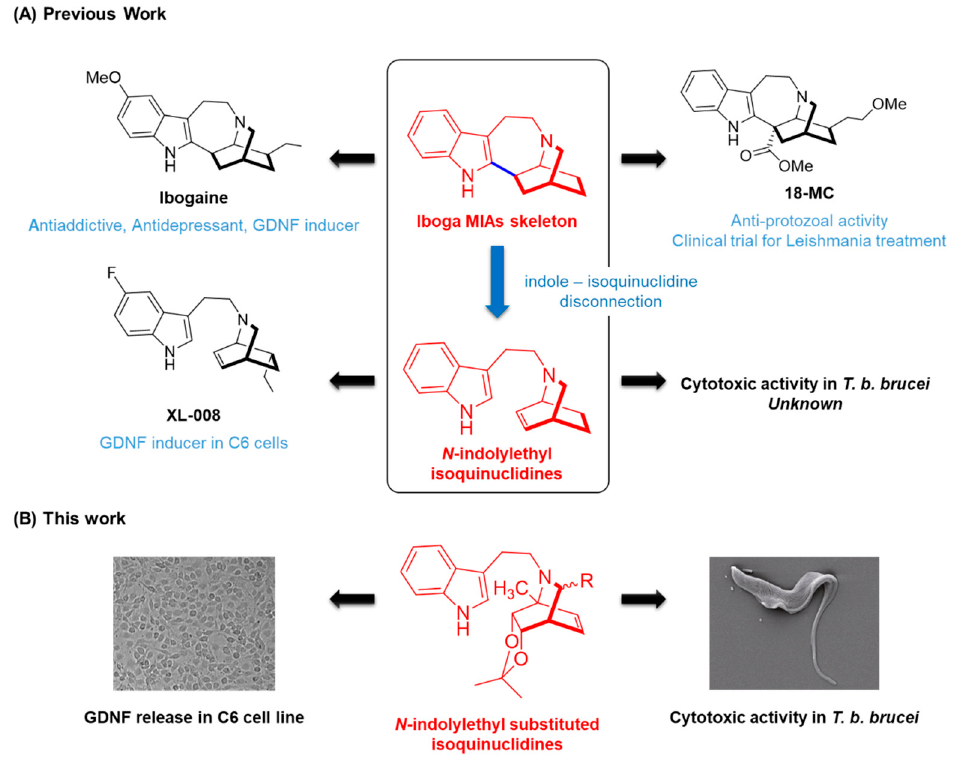
Figure 1. Iboga alkaloids have been investigated for their variety of pharmacological effects, such as induction of GDNF expression in the central nervous system (ibogaine) and anti-protozoal activity (18-MC). In this work we study these activities in inspired simplified analogs such as enantiomerically pure N -indolylethyl-substituted isoquinuclidines.